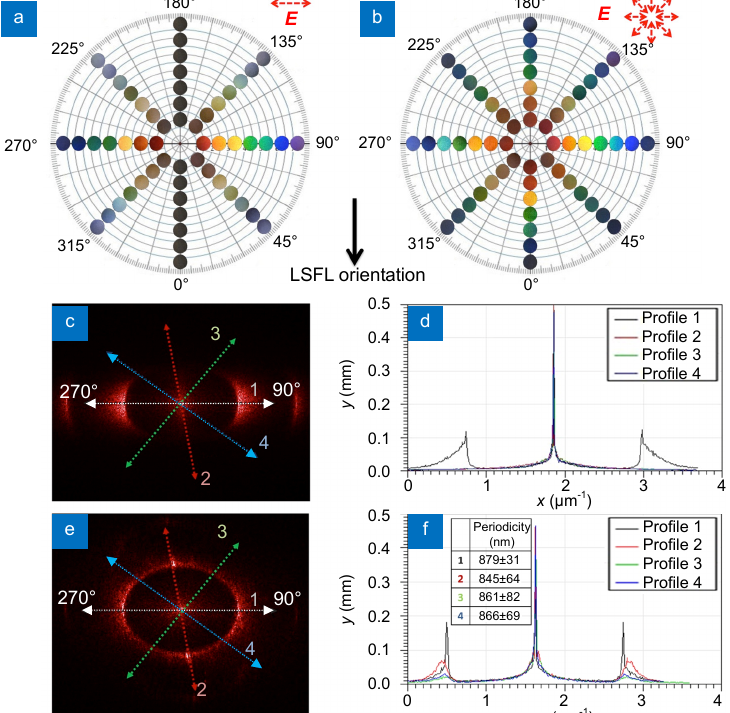
Fig. 5 | Schematic illustration of the structural colors observed the S 1 (a) and the S 2 (b) sample series respectively; 2D-FFT patterns corresponding to the S 1 (c) and the S 2 (e) sample series respectively. The corresponding intensity plots of the 2D-FFT patterns in four different directions (denoted as ‘1’ to ‘4’) are depicted in (d) and (f) respectively. Inset in (f) displays the periodicity values of LSFL structures for a series of four cross-sections taken in the Fourier image of the S 2